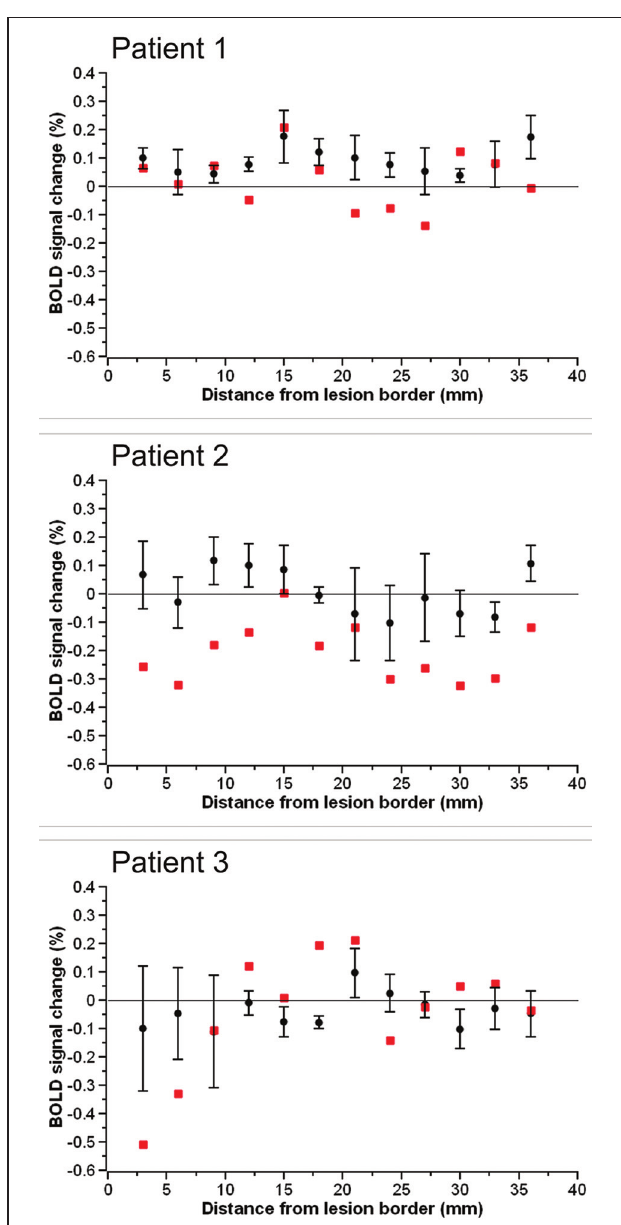
FIGURE 3 | The interhemispheric imbalance score in each 3 mm perilesional region for each of the three stroke patients (red squares) as well as the group of three control subjects assigned to the respective patient (black circles). Error bars reflect standard error of the mean.